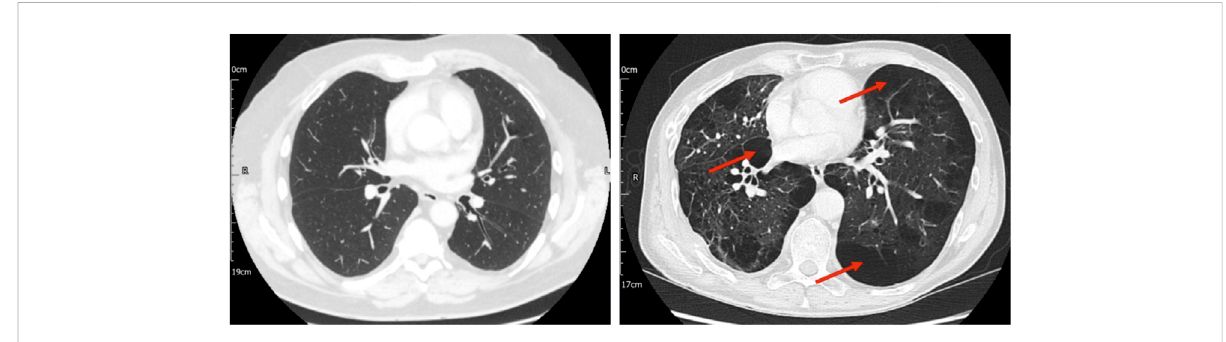
FIGURE 3 Computedtomography (CT) imagingfor two patients with stage 2COPD, one ofwhom had no CTevidenceof emphysema(left panel) and the other of whom had signi fi cant paraseptal and centrilobular emphysema (right panel), with bullae (examples indicated by arrows). Both patients had signi fi cantly elevated σ CL(0.76 and1.06, respectively). Inthepatientwithout CT evidence ofemphysema, theestimated total anatomical deadspace volume was normal (0.169 L). In the patient with CT evidence of emphysema, the estimated deadspace volume was substantially elevated (0.502 L). This highlights the possibility that lung inhomogeneity testing might not only represent a means of identifying COPD, but also of providing information about the underlying disease